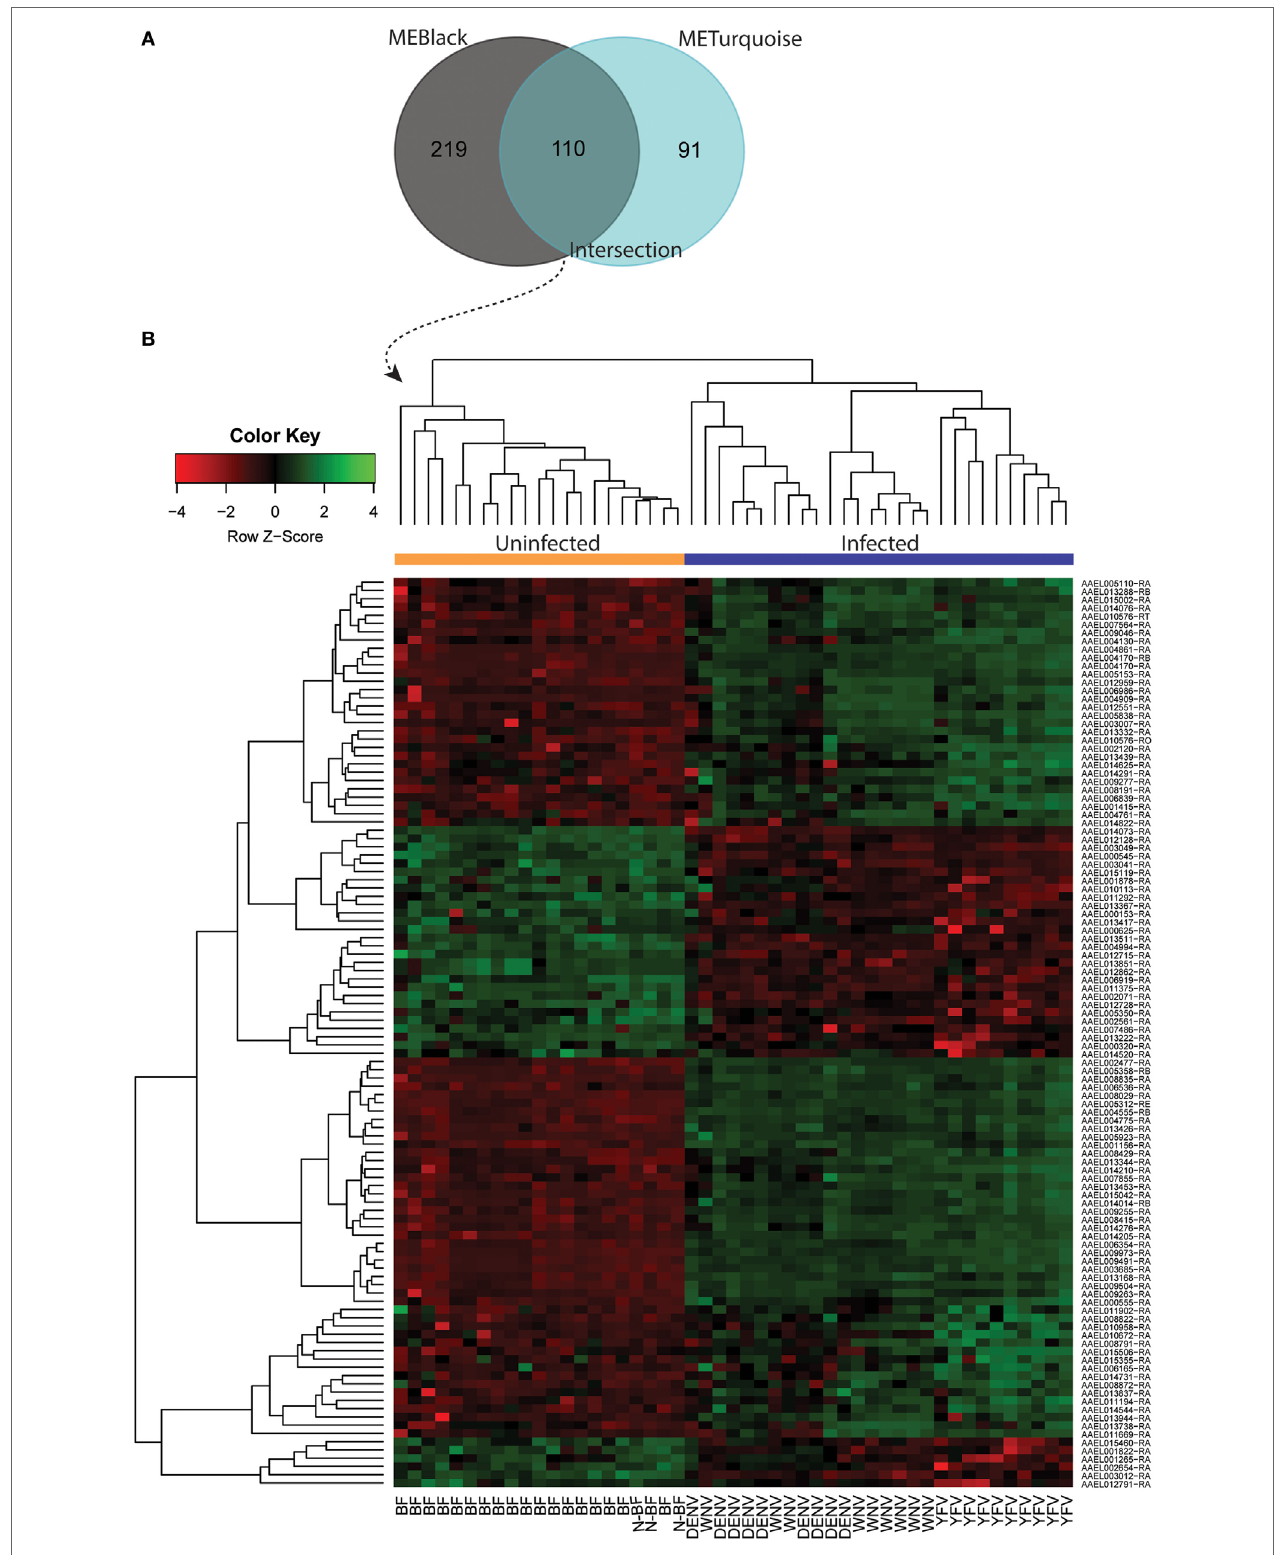
FigUre 5 | Infection-specific genes identification by removing the blood-feeding noise. (a) Venn diagram with genes present within the black and turquoise modules. (B) Hierarchical clustering and heatmap of 110 genes present in the